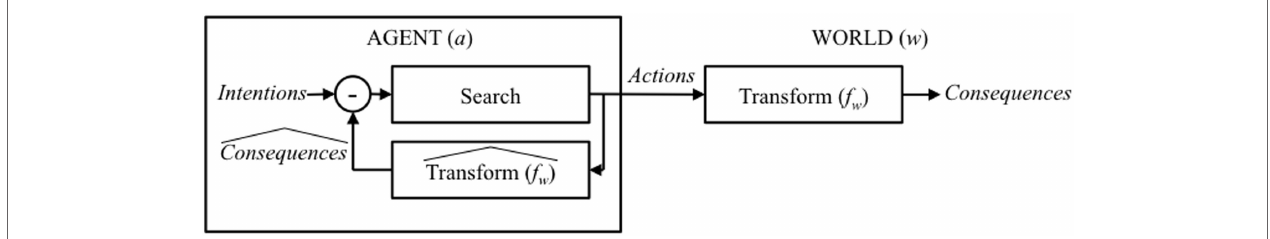
FIGURE 5 | Illustration of an intentional agent manipulating the world in a closed-loop configuration in the situation where the agent is unable to directly observe the consequences of its actions (in space or time).